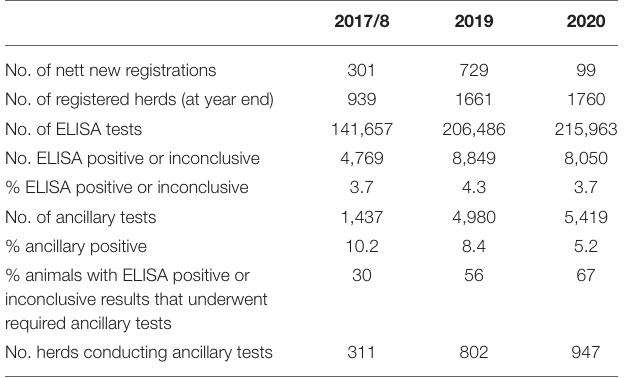
TABLE 1 | Summary of registered herds and testing results for the calendar years 2018–2020.